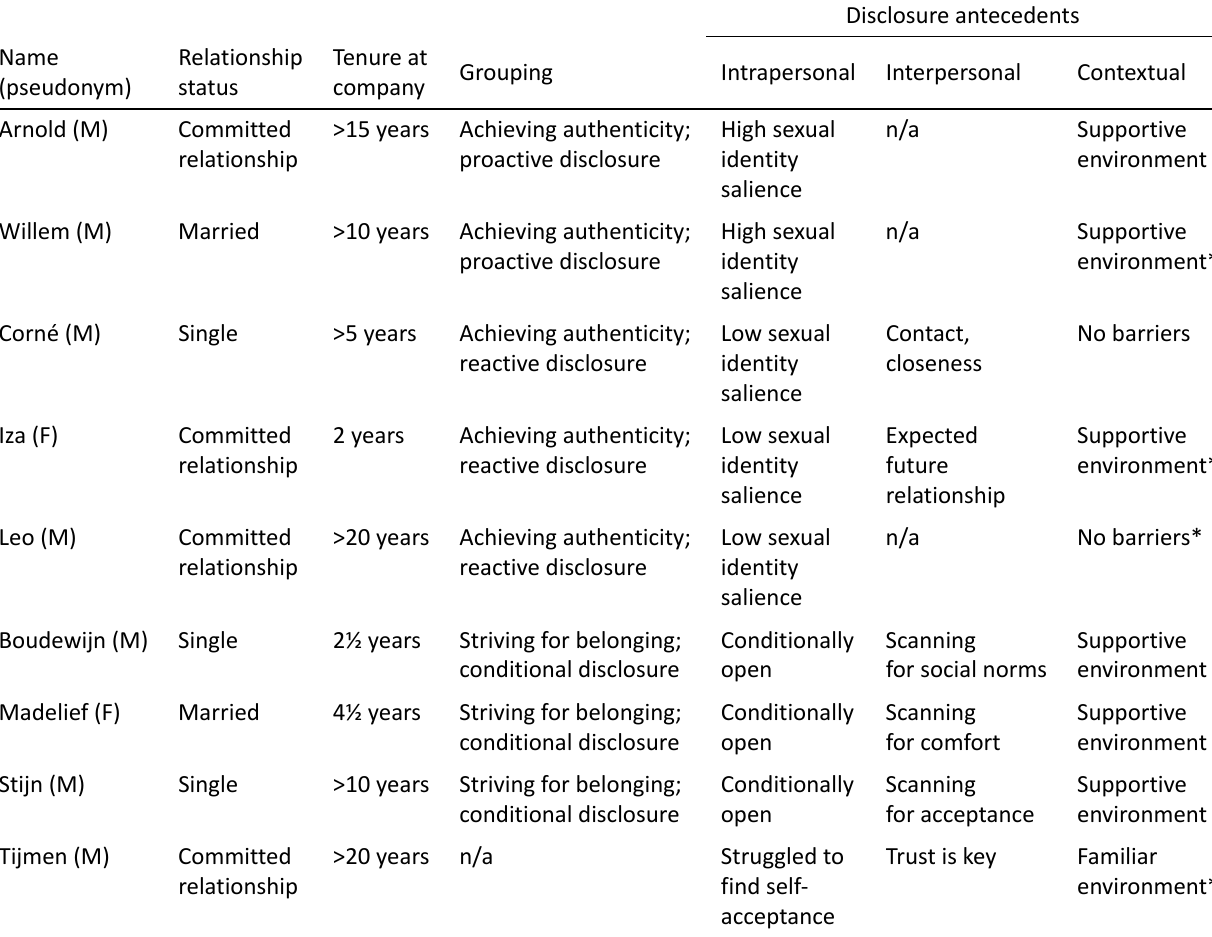
Table 1. Participant details, groupings, and disclosure